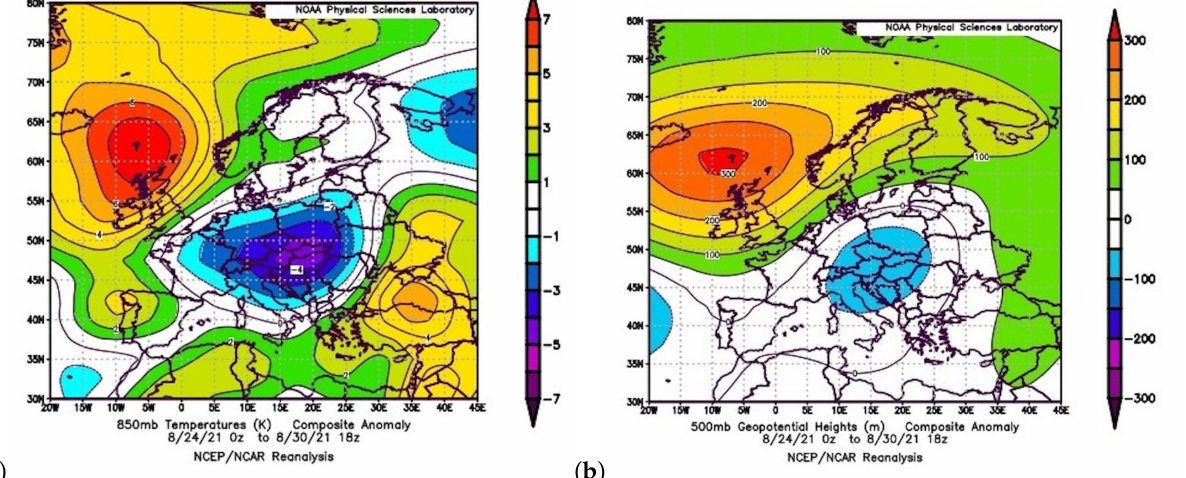
Figure 6. Maps of composite anomalies of ( a ) temperature at 850 hPa and ( b ) geopotential height at 500 hPa for the period 24–30 August